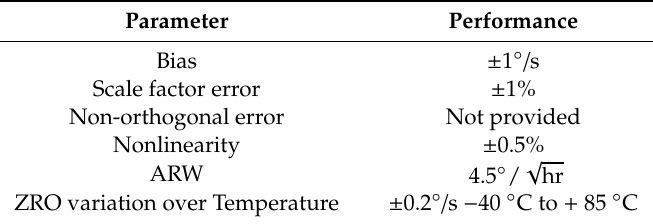
Table 4. Crossbow IMU440